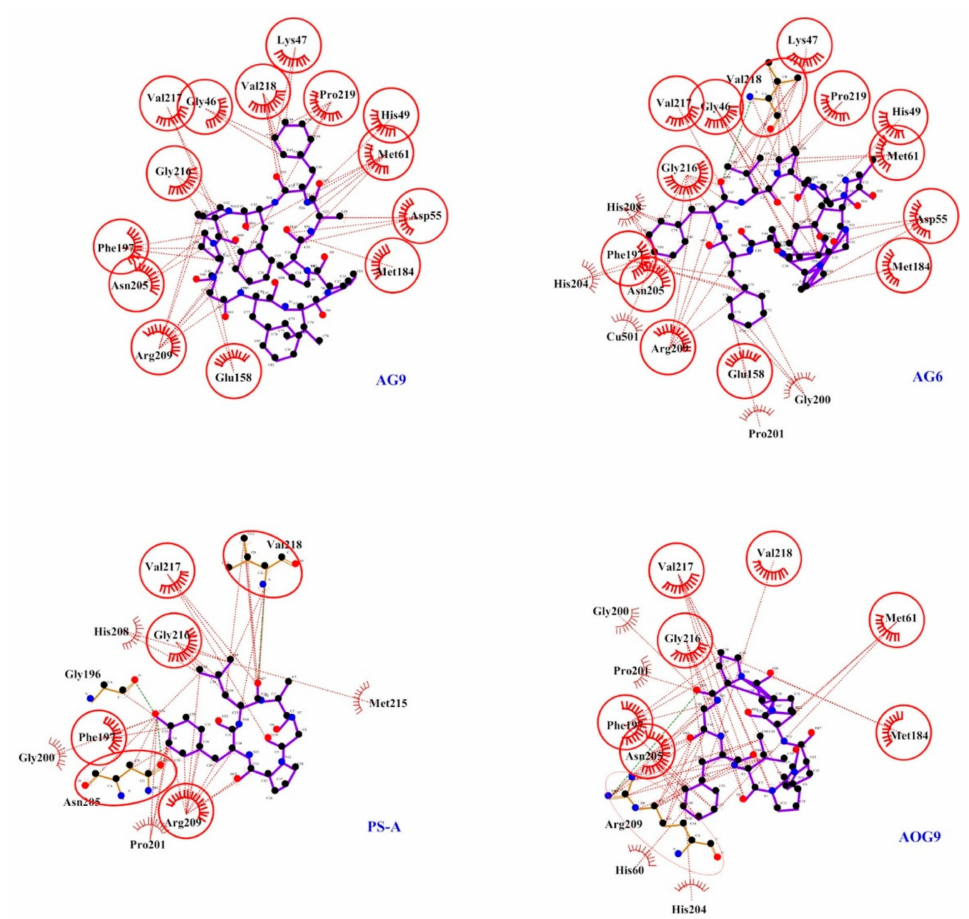
Figure 6. Hydrophobic interactions of the lowest docking poses of AG9 , AG6 , PS-A and AOG9 with the catalytic site of B. megaterium tyrosinase (PDB file: 3NM8) performed with LigPlot+